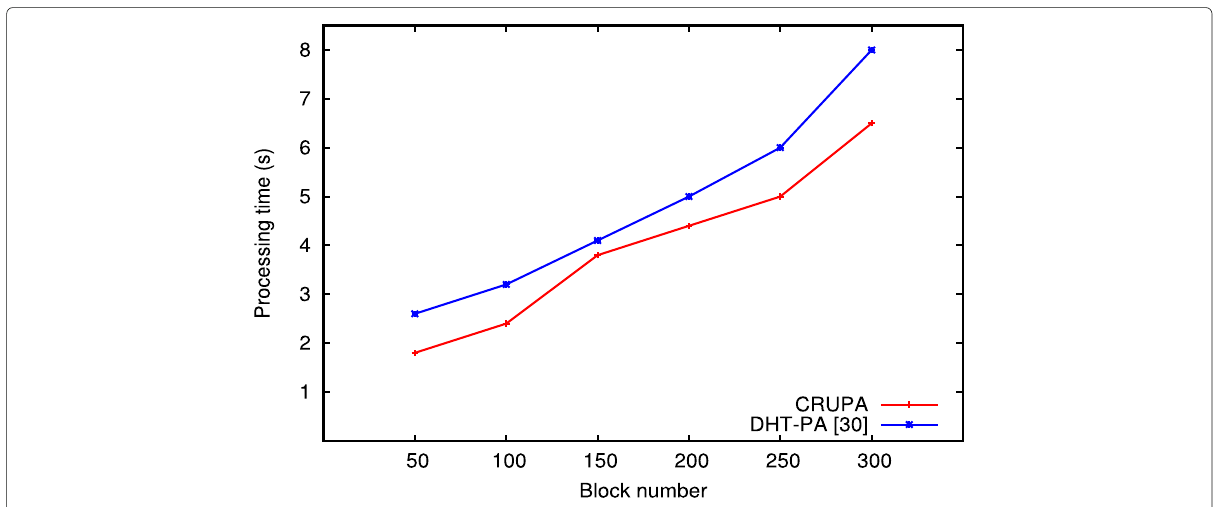
Footnote The 1 Re − sign key computed by the information pro- prietor using the regression technique mentioned in this paper must be considered as an indication. Since, the Re − sign key is computed by the IP using regression tech- nique, it is not possible by the CSP by colluding with the revoked customer to break the Re − sign key and find the secret keys of the customers. Hence the proposed scheme preserves the privacy of the customers and is collusion resistant. Further, the proposed scheme supports effec- tive and secure customer repudiation, multi-information proprietor batch auditing and is